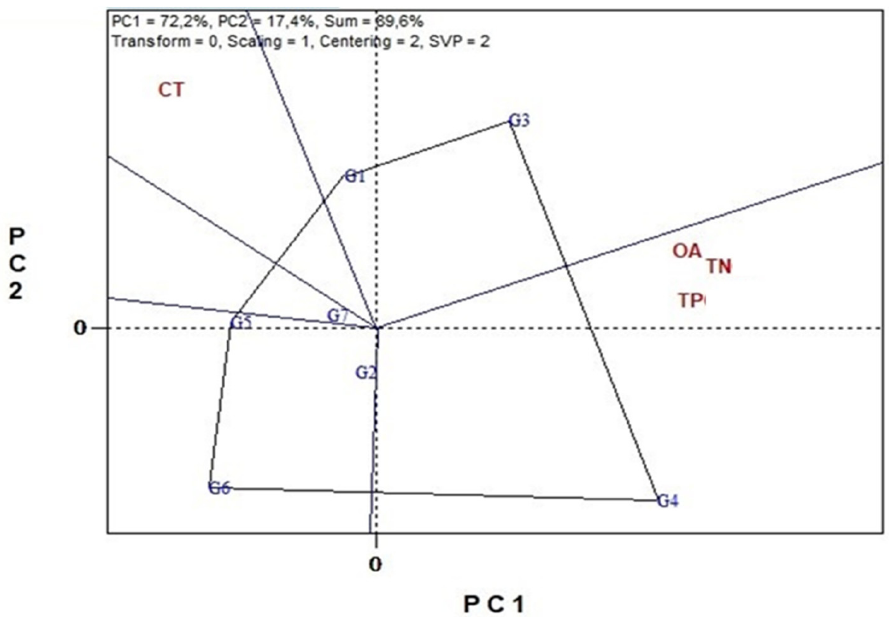
Figure 8. “Which-won-where or which is best for what” view of the GGE biplot for genotypes by antinutritional traits representing seven V. sativa genotypes measured for four traits averaged across six environments.